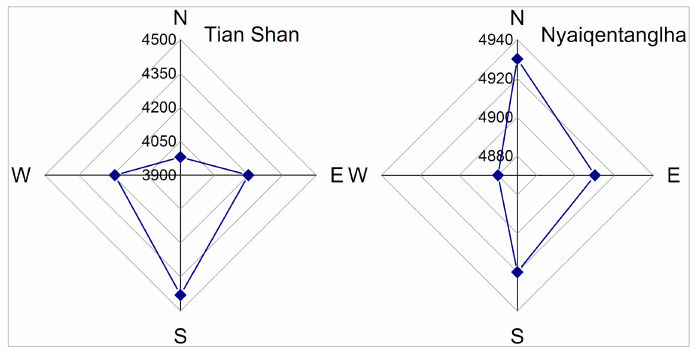
Figure 14. Glacier SLA in different orientations in the Tian Shan and the Nyainqentanglha Mountains. There was a sharp decrease in precipitation from the eastern and southeastern marginal mountains of the Tibetan Plateau to the west and northwest during the 1989–2019 period, whereas the maximum temperature occurred in the western region of the Tibetan